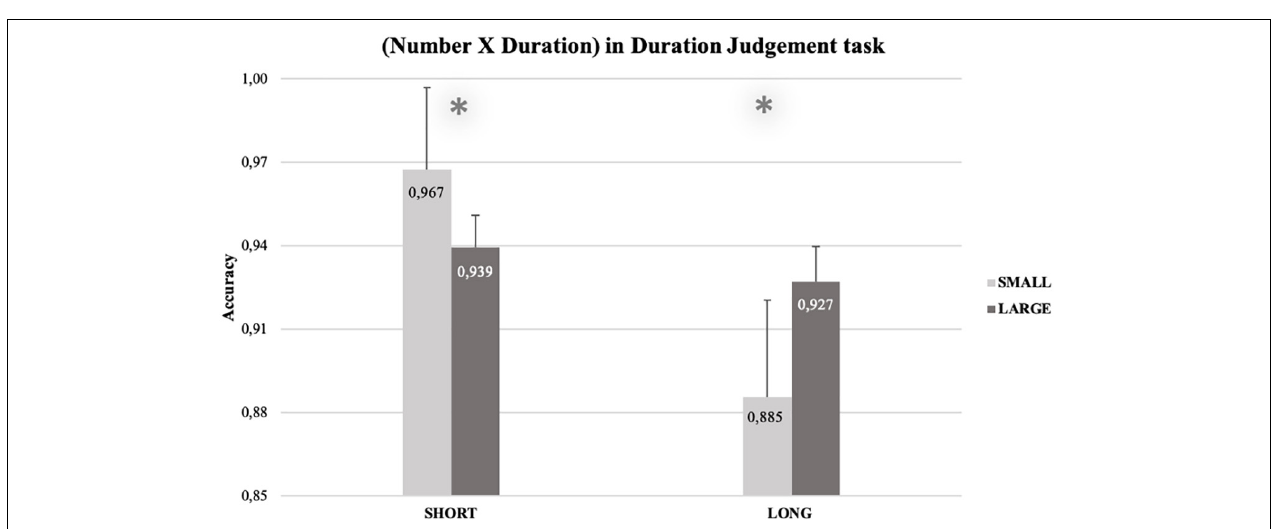
FIGURE 3 | Percentage of correct answers for the number comparison task, as a function of Duration (short vs. long) and Number (small vs. large). Accuracy for numbers larger than 5 was higher when they were preceded by long durations ( M = 0.983, SEM = 0.004) than by short ones ( M = 0.961, SEM = 0.006). The error bars indicate confidence intervals (95%), corrected for within-participants designs (O’Brien and Cousineau, 2014; single method).